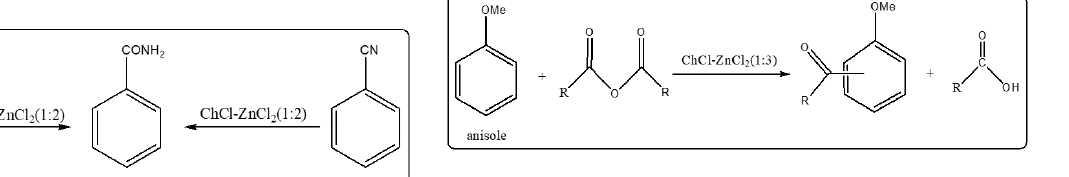
Figure 2: Synthesis of amides from aldehydes and nitriles catalyzed by ChCl-ZnCl